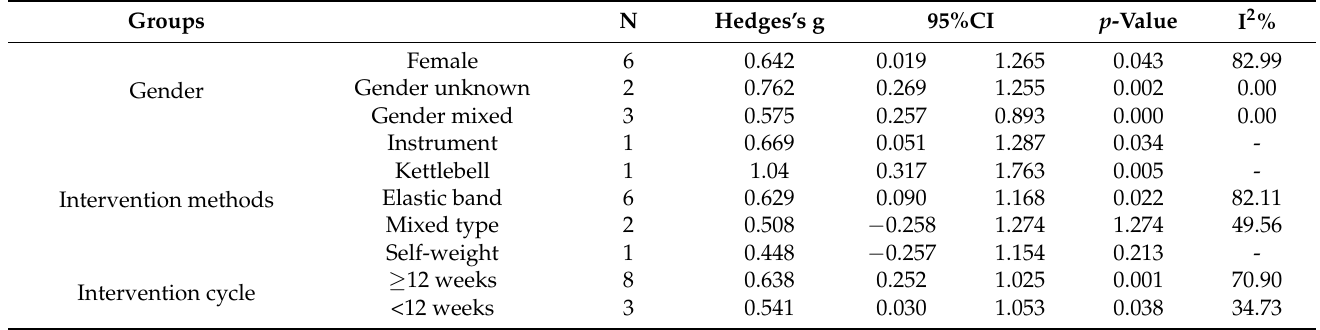
Table 3. Subgroup analysis of the effect of resistance training on grip strength of elderly patients with sarcopenia.